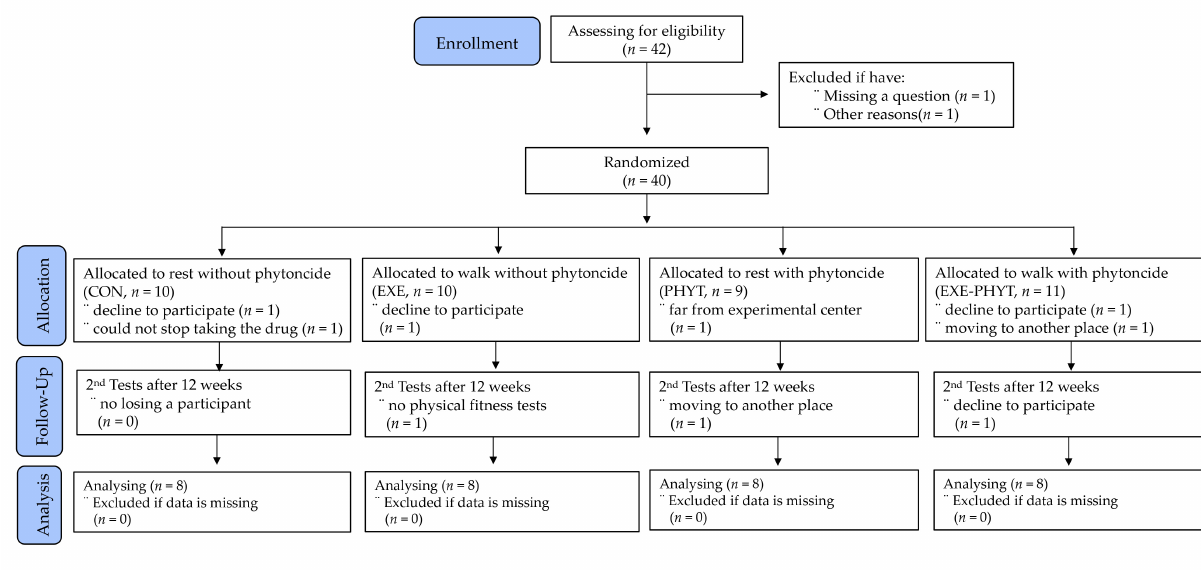
Fig. 1. Participants’ allocation (consolidated standards for reporting of trials flow diagram). Table 1. Physical characteristics of the participants. Groups without phytoncide Groups with phytoncide